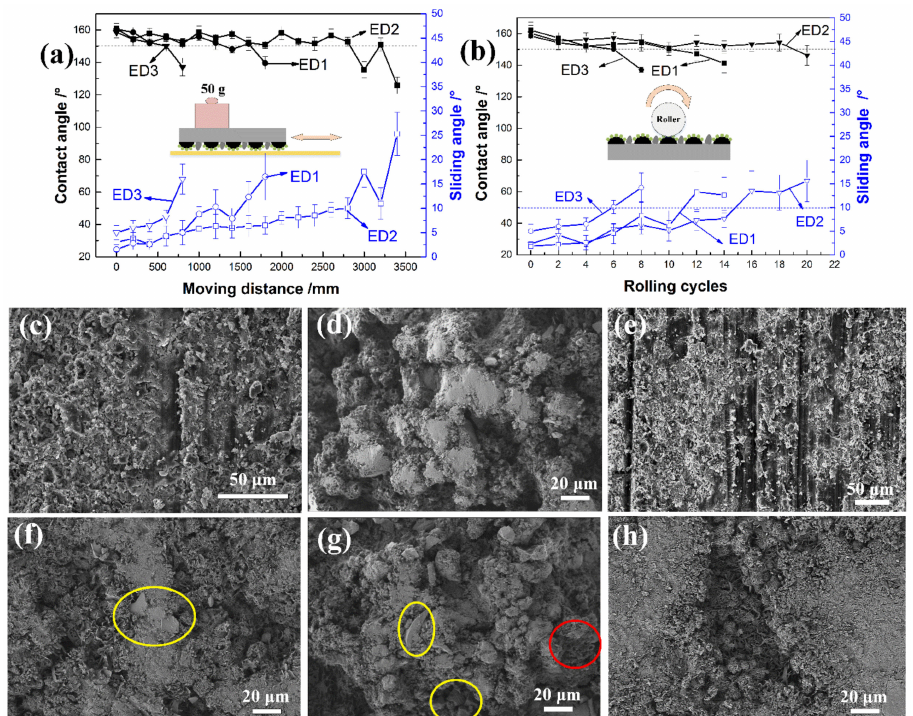
Figure 6. The mechanical durability test of samples: ( a ) CAs and SAs with moving distance; ( b ) CAs and SAs with rolling cycles; ( c ) morphology of ED1 sample after abrasion test; ( d ) morphology of ED2 sample after abrasion test; ( e ) morphology of ED3 sample after abrasion test; ( f ) morphology of ED1 sample after rolling test; ( g ) morphology of ED2 sample after rolling test; ( h ) morphology of ED3 sample after rolling test.